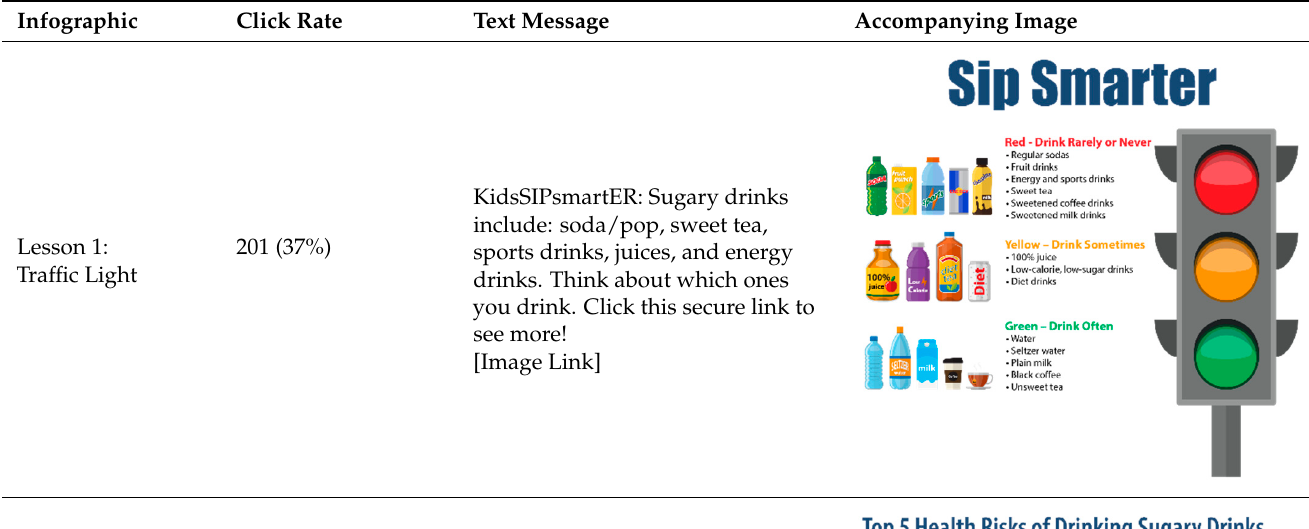
Table 1. Infographic images and enrolled caregiver ( n = 542) total link click rates.